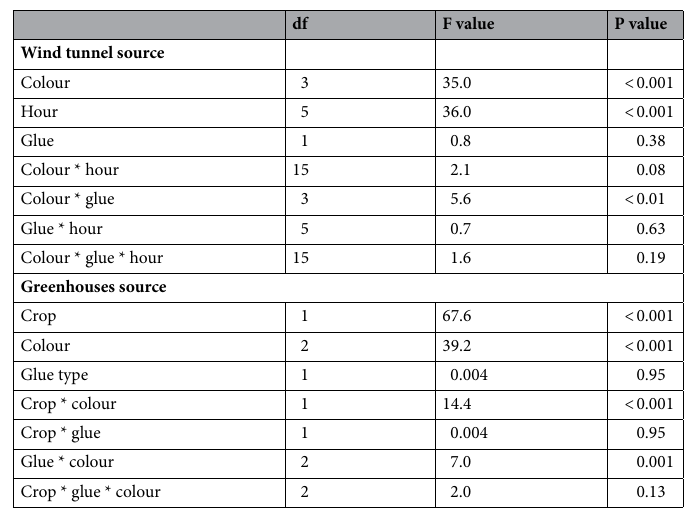
Table 1. Linear mixed model (LMML) for the effects of the independent variables. The applied model of estimation (REML) attributes to the number of western flower thrips caught on coloured sticky plate traps in the wind tunnel and two greenhouses (rose and chrysanthemum). The sample size is N = 144 (wind tunnel) and N = 175 (greenhouses), the value of the Akaike information criterion is 140.3 (wind tunnel) and 1703.6 (greenhouses), and the repeated covariance type of the repeated measure (h) is Unstructured (windtunnel). The number of thrips in the windtunnel data was LN (+ 1) transformed to meet the requirements of the test.